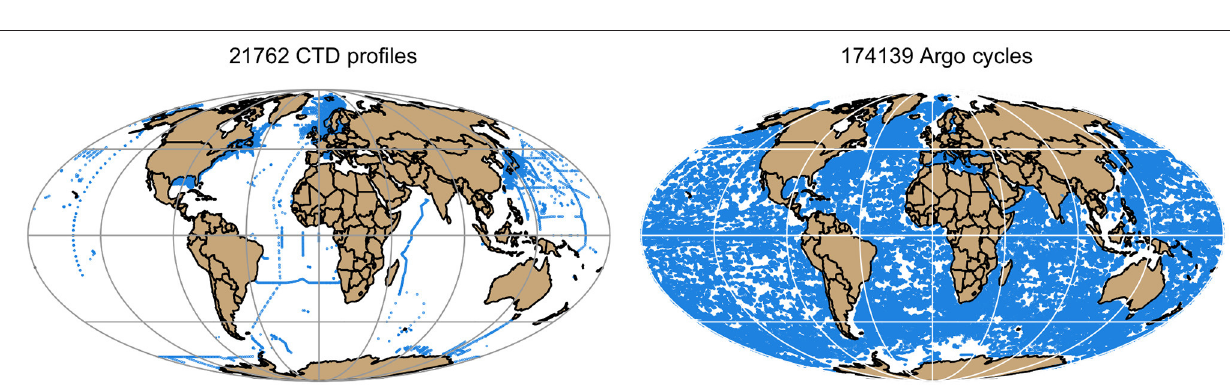
FIGURE 2 | Comparison of spatial sampling during the year 2018 using ship-born CTDs (Left) and Argo floats (Right) . The CTD data were obtained from the World Ocean Database and plotted with the oce package, and the Argo data were downloaded and plotted using argoFloats . The respective profile counts (for CTD) and cycle counts (for Argo) are indicated above the